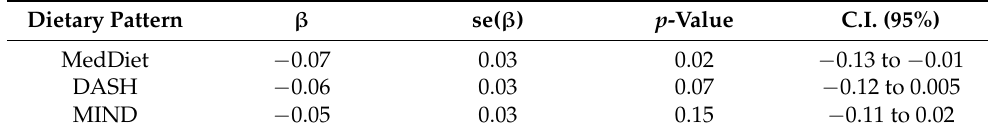
Table 3. Average Treatment Effects (ATE) on FLI. Dietary